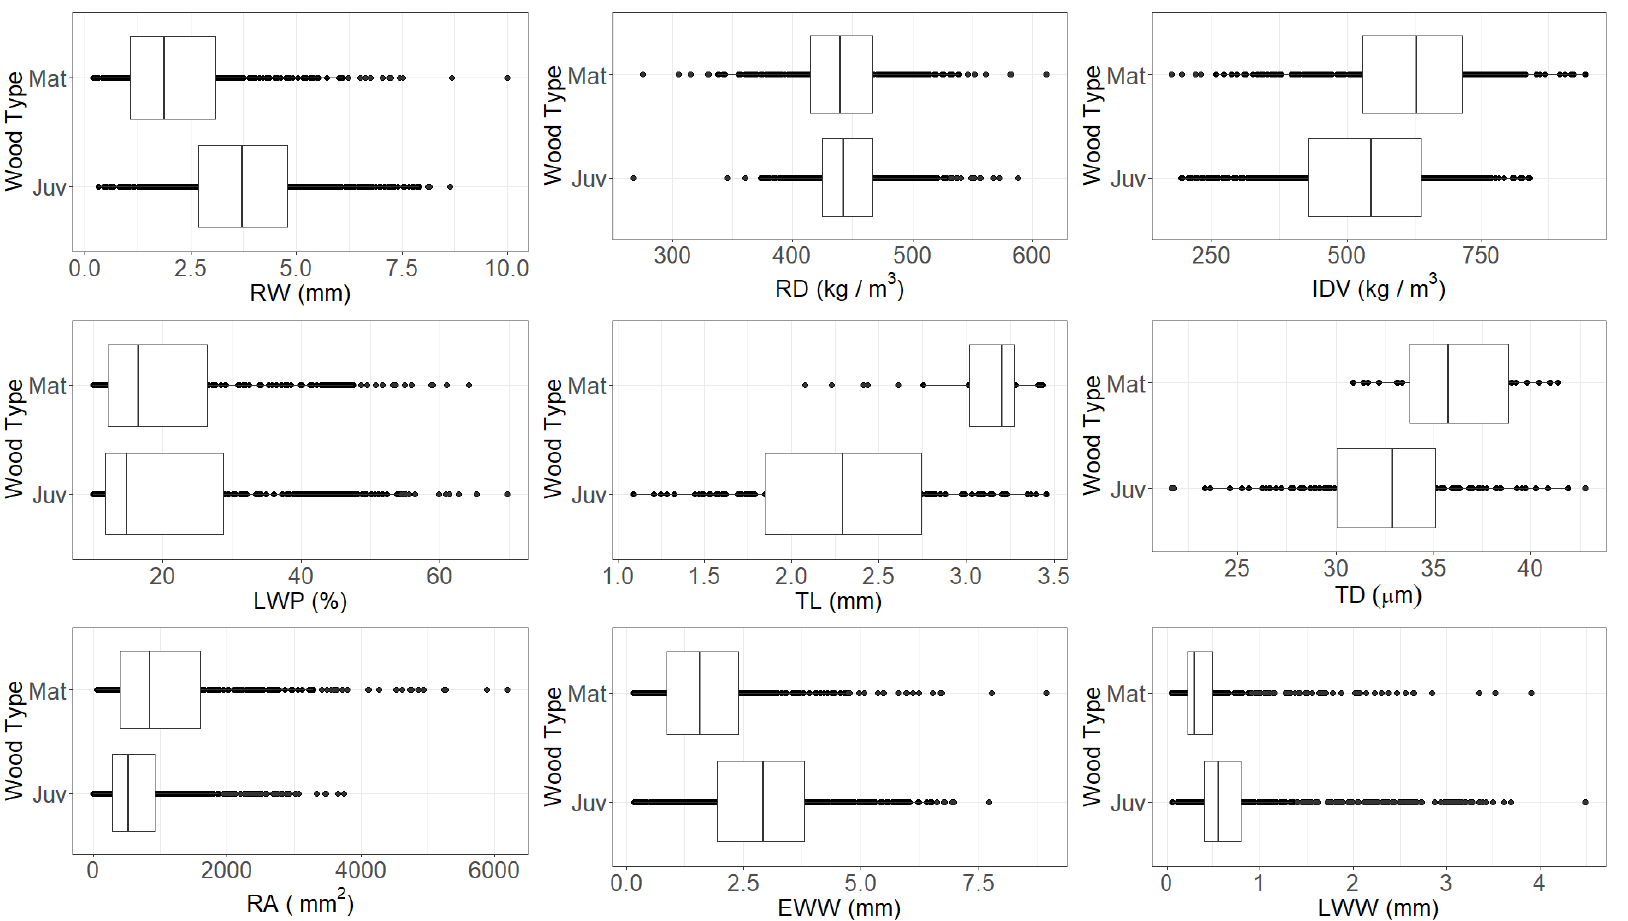
Figure 2. Radial variation of wood type (Juv: Juvenile, Mat: Mature), at the stem scale, of wood quality attributes of white spruce. For each wood type, the dispersion of data for a given wood quality attribute is represented by the interquartile range (distance between the upper and lower quartiles) and also the minimum and the maximum values. The wood quality attributes are: RW: ring width, RD: ring density, IDV: intra-ring density variation, LWP: latewood proportion, TL: tracheid length, TD: tracheid diameter, RA: ring area, EWW: earlywood width, and LWW: latewood width.